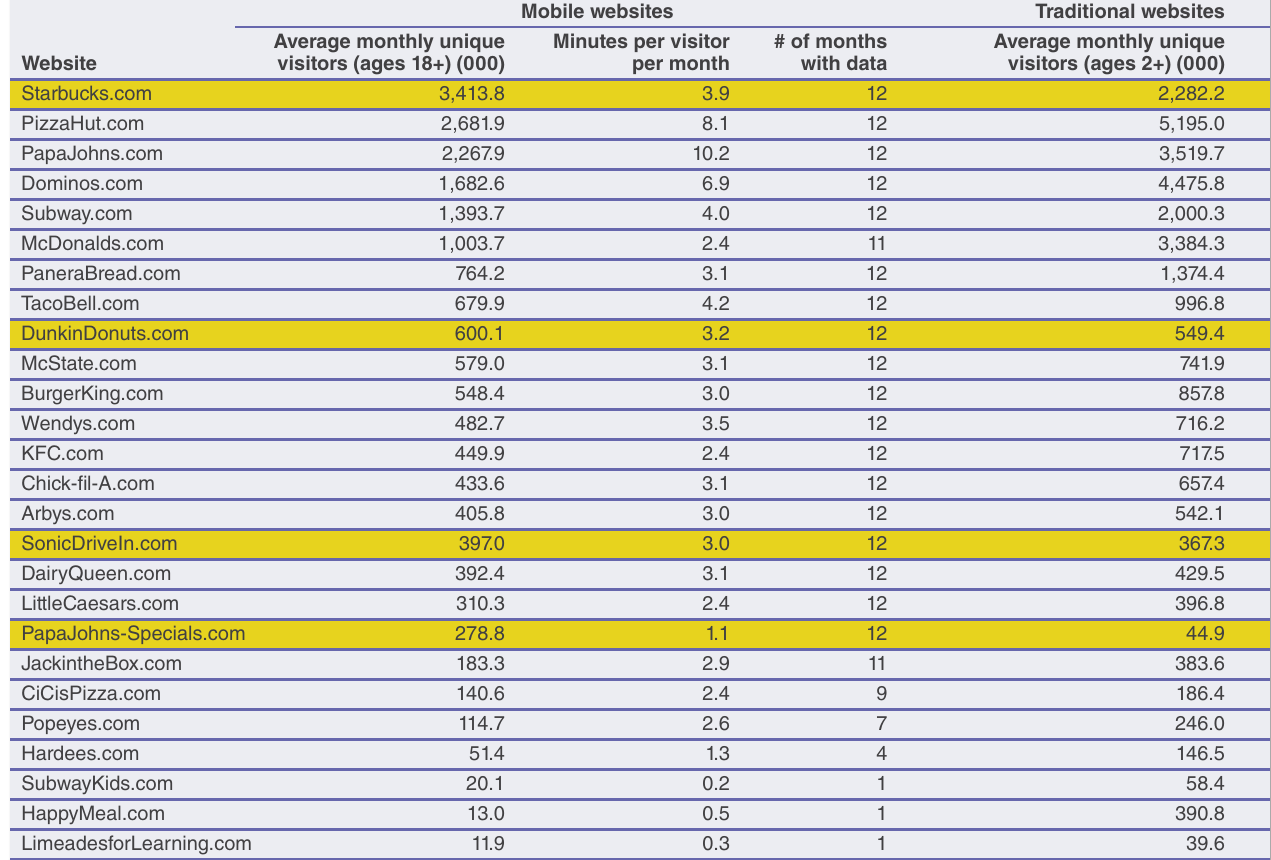
Table 32. Average monthly unique visitors to mobile and traditional fast food